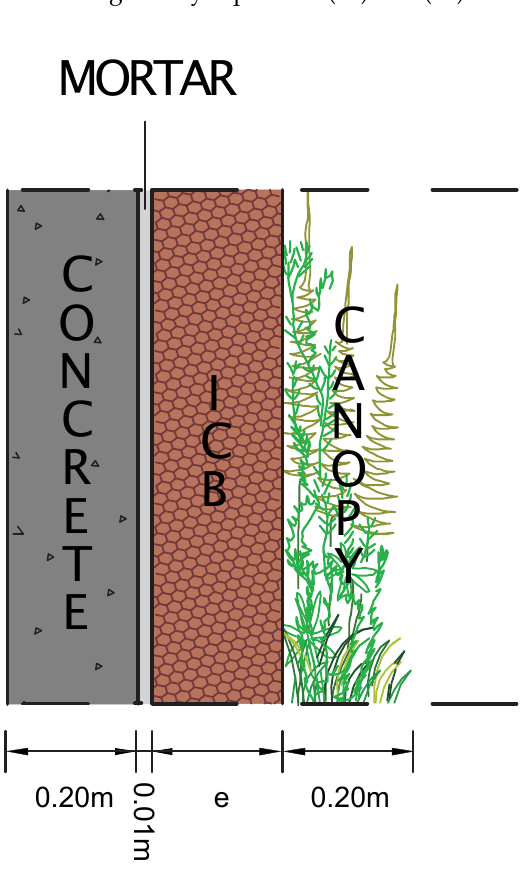
Figure 12. Four-layer greenery system (canopy-ICB-mortar-concrete wall